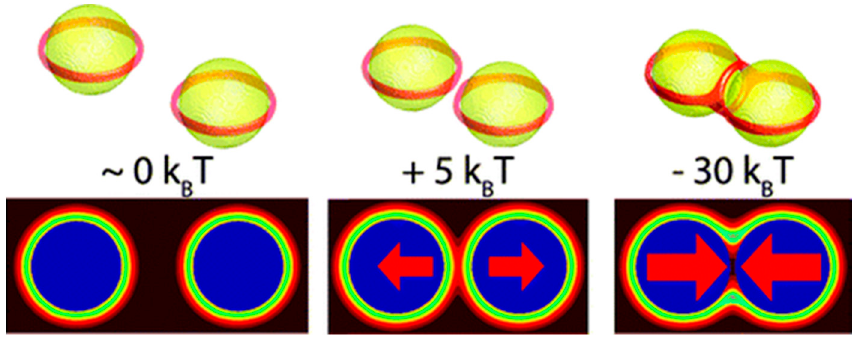
Figure 7. Three-dimensional representation of the defect structure and contour plot of the scalar order parameter S along the horizontal plane passing through the center of two nanoparticles, with R = 25 nm and strong anchoring with W = 10 mJ/m 2 . ( a ) Distance between particles of r = 80 nm, ( b ) r = 40 nm and ( c ) r = 10 nm. Notice that once the separation between particles is the same order of magnitude as the nematic-coherence length, the defects interact to form a three-ring structure. Reproduced with permission from Ref. [87]. (American Chemical Society).